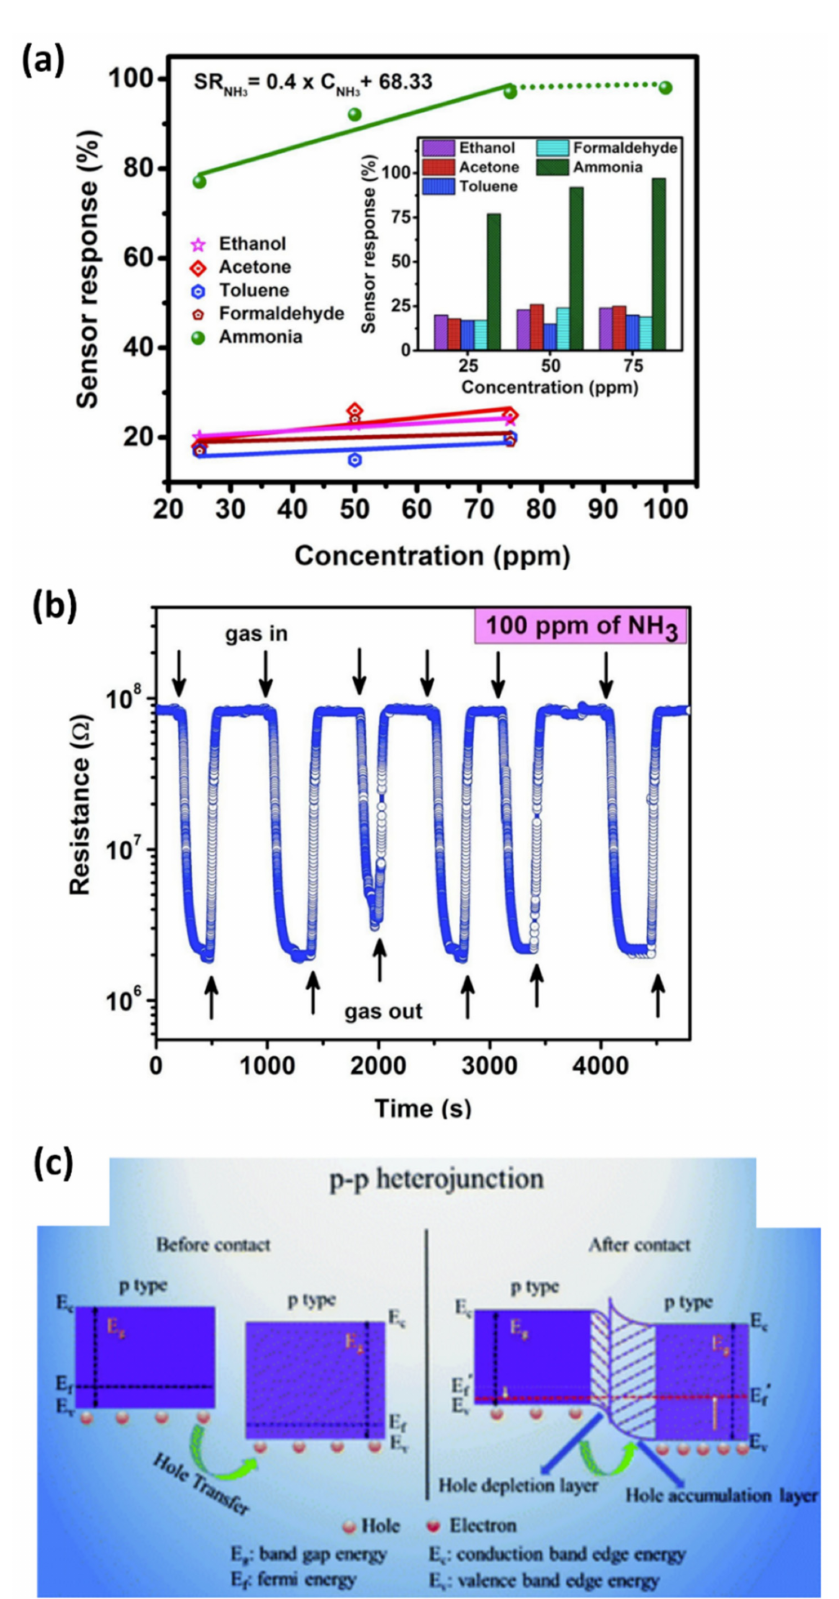
Figure 18. ( a ) Response and selectivity of Cr 2 O 3 /CuO thin films at RT towards many NH 3 concen- trations over several gases. ( b ) Repeatability of Cr 2 O 3 /CuO thin film for 100 ppm of NH 3 at RT. Reprinted with permission from [154]. ( c ) Energetic-band diagram of pp heterojunction. Reprinted with permission from